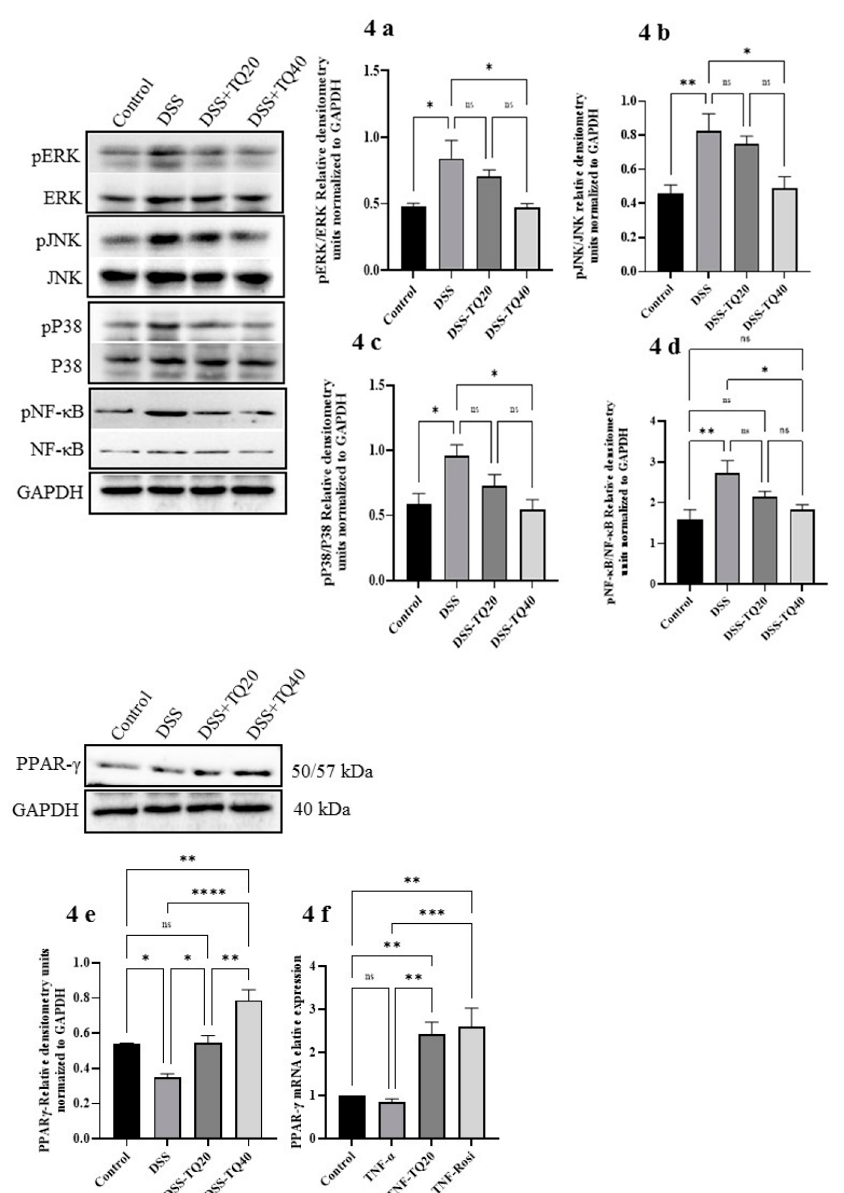
Figure 3. Effects of TQ on proinflammatory cytokines and mediator protein and mRNA expres- sion. TQ treatment significantly prevented the DSS-induced increases in concentrations of proin- flammatory cytokines both at protein (IL-6 ( a ), IL-1 β ( b ), and TNF- α ( c )) and mRNA expression levels (IL-6 ( d ), IL-1 β ( e ), and TNF- α ( f )) in DSS-induced colitis group. Similarly, TQ treatment (20 mg/kg bd wt) failed to show a statistically significant decrease in the phosphorylation also significantly decreased COX-2 and iNOS levels both at protein and mRNA levels in the DSS- of these MAPK signaling pathway proteins. DSS treatment significantly ( p < 0.01) increased induced colitis group ( g – j ). The density of the immunoblots was normalized to GAPDH as an in- phosphorylation of the NF- κ B protein (Figure 4d; p < 0.05). The higher dose of TQ treatment ternal control. n = 8 animals used for obtaining data for proinflammatory cytokines (IL-6, IL-1 β , (40 mg/kg bd wt) significantly decreased phospho-NF- κ B protein ( p < 0.05) compared to and TNF- α protein and mRNA) and n = 4 animals used in each group for proinflammatory media- the DSS-treated group. However, the lower TQ treatment dose (20 mg/kg bd wt) failed to tors (COX-2 and iNOS protein and mRNA) expression studies. The data expressed as means ± SEM. **** p < 0.0001 , *** p < 0.001 , ** p < 0.01 , and * p < 0.05. (NS) not significant. show a statistically significant decrease in phospho-NF- κ B protein.